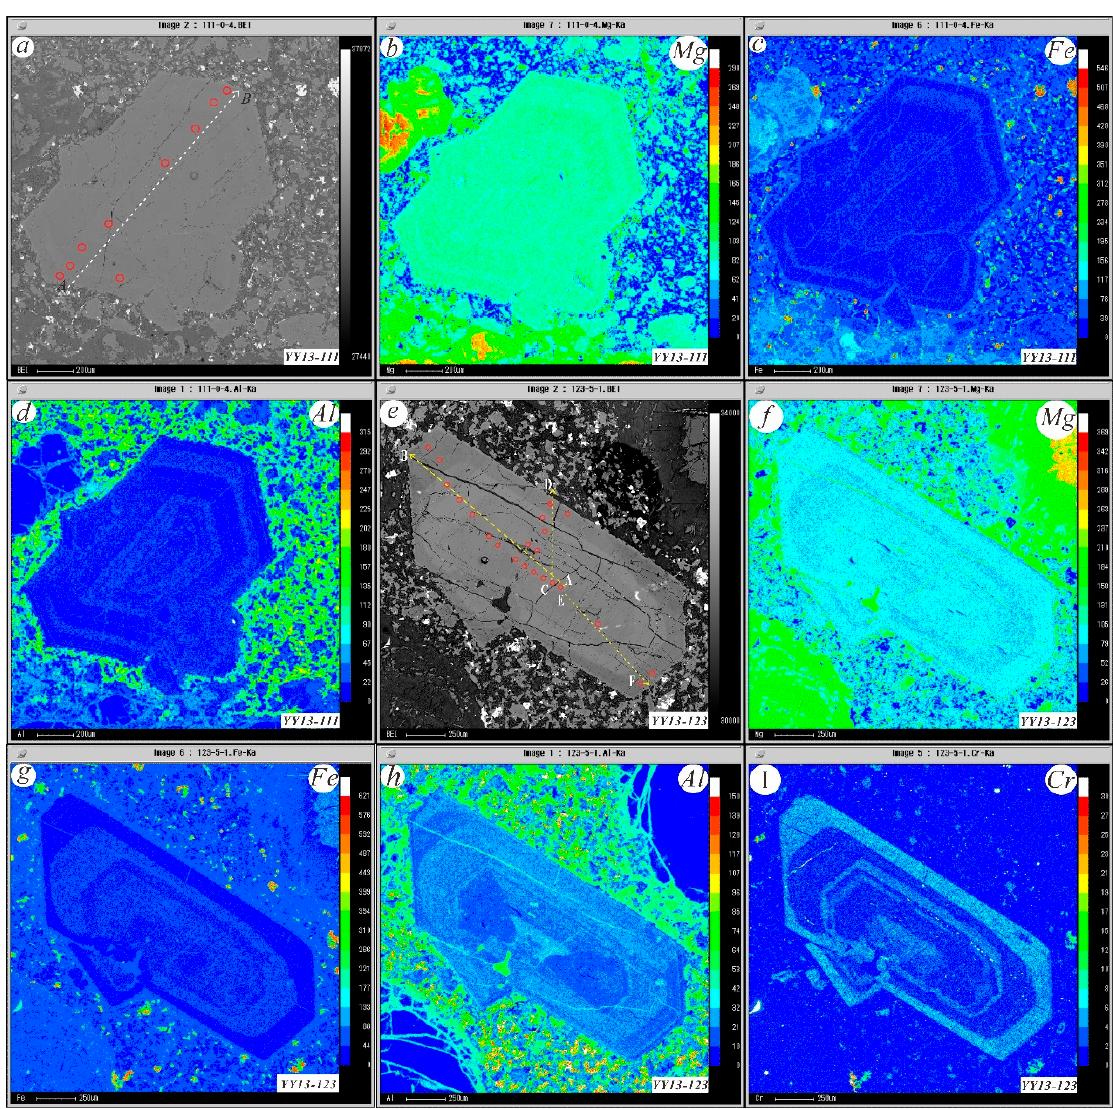
Figure 6. ( a , e )The back-scattered electron images of the Cpx crystal from the high-Mg basalt sample YY13-111 and YY13-123, respectively, the detail data of the white dotted arrows from A to B are presented in Figures 7, 8 and Supplements Figure S3. ( b – d ) and ( f – i ) qualitative WDS maps of Mg, Fe, Al and Cr.